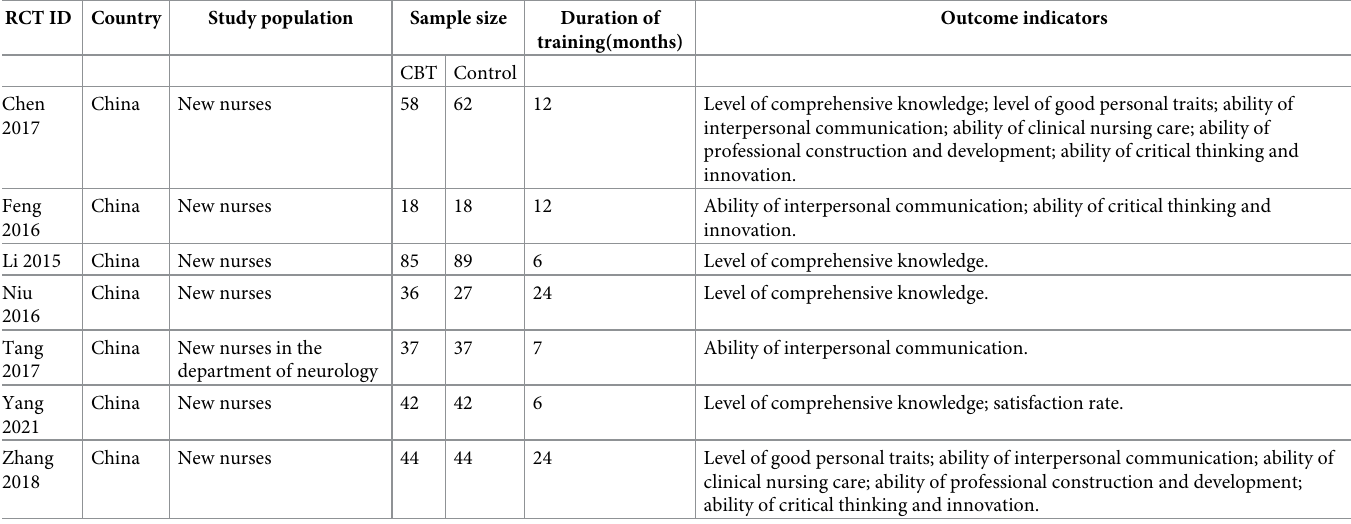
combined results showed that the ability of clinical nursing care of the CBT group was better